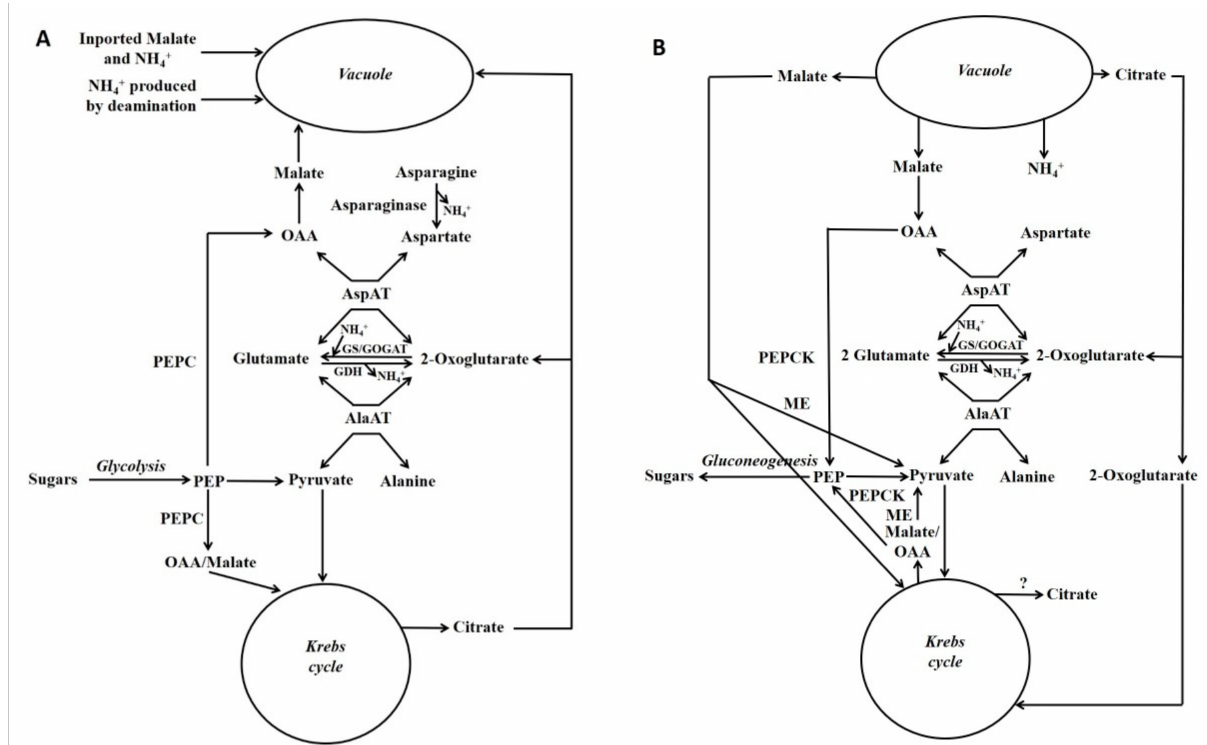
Figure 3. Gluconeogenesis from malate and its association with nitrogen metabolism. Simplified scheme depicting gluconeogenesis associated with the metabolism of asparagine or ammonium: storage phase of these metabolites ( A ); utilisation phase ( B ) (Reproduced from Walker et al. [7]). Fluxes through different reactions in the schemes will differ according to factors such as which nitrogenous compound (e.g., asparagine [e.g., maize pedicel], glutamine or ammonium [e.g., maize root fed ammonium]) is the major input. Glutamate, aspartate, pyruvate and PEP are the precursors of most amino acids [105], and in both situations these metabolites could be produced. GDH = glutamate dehydrogenase; GOGAT = glutamine oxoglutarate aminotransferase; GS = glutamine synthase; ME = malic enzyme; OAA = oxalacetate; PEP = phosphoenolpyruvate; PEPC = phosphoenolpyruvate